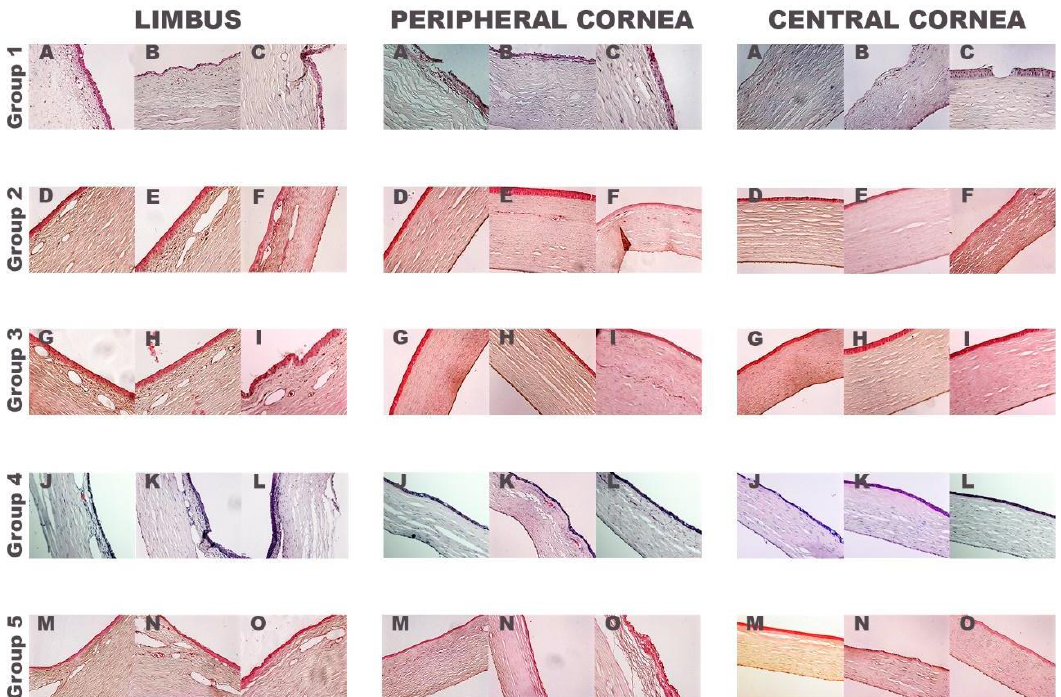
Figure 4. Histological analysis of rabbit corneas. Hematoxylin-eosin photographs of the three treated rabbits’ corneas of each group. Group 1: only medical treatment (control group), Group 2: fibrin-PRGF membrane cultured with autologous rabbit LEPCs, Group 3: fibrin-PRGF membrane cultured with heterologous rabbit LEPCs, Group 4: fibrin-PRGF membrane SLET and Group 5: fibrin-PRGF membrane without rabbit cultured LEPCs. 200 × . PRGF: Plasma Rich in Growth Factors; LEPCs: Limbal Epithelial Progenitor Cells; SLET: Simple Limbal Epithelial Transplantation.